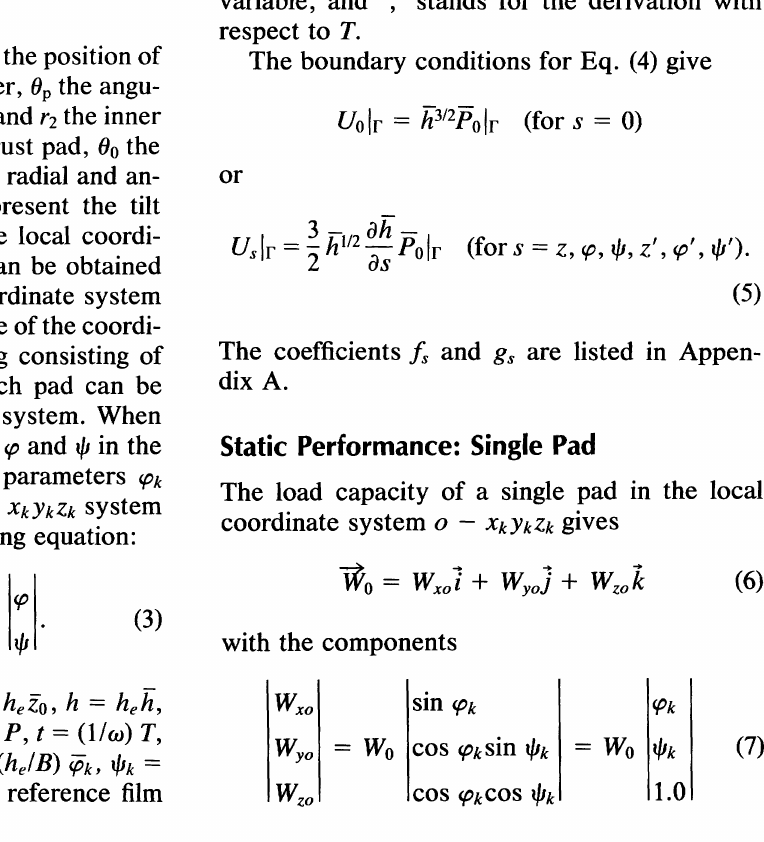
FIGURE 2 (a) Thrust bearing and (b) oil film thick